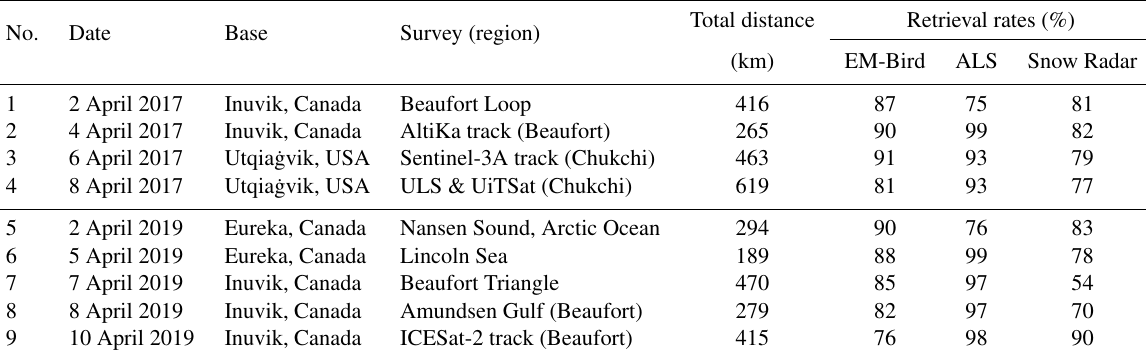
Table 1. IceBird surveys in 2017 and 2019 in the focus of this study (Fig. 2) together with their total lengths and instrument retrieval rates.